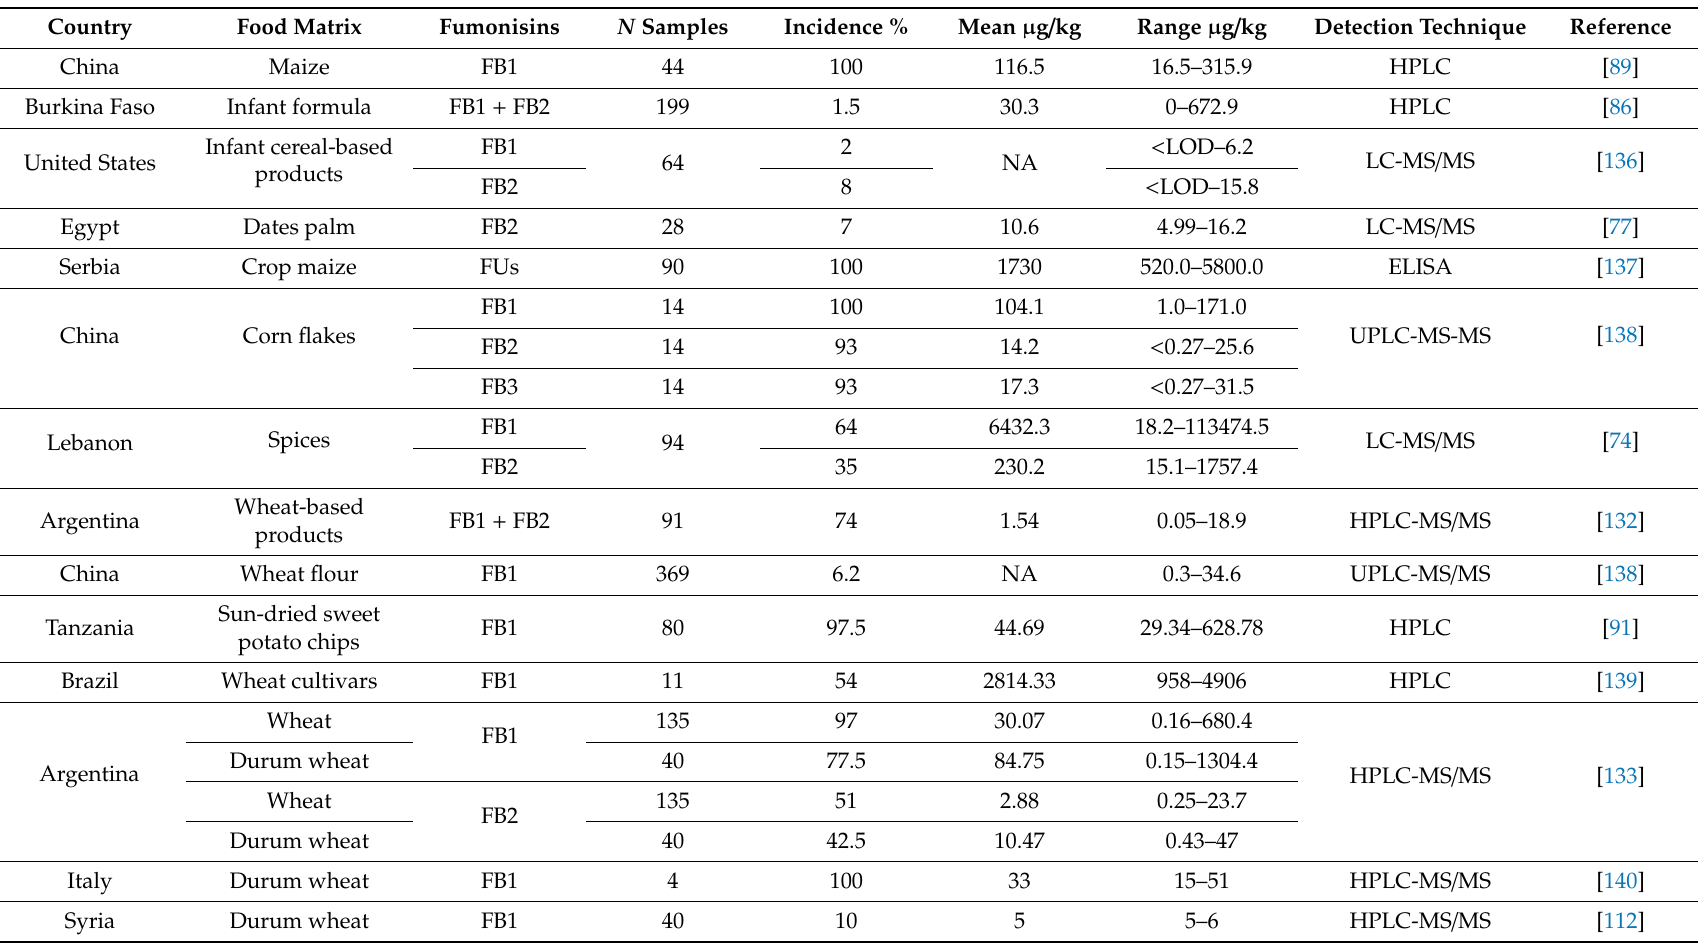
Table 6. Representative studies on the occurrence of fumonisin (FU) distribution ( µ g / kg) in food samples around the world during 2014–2019.